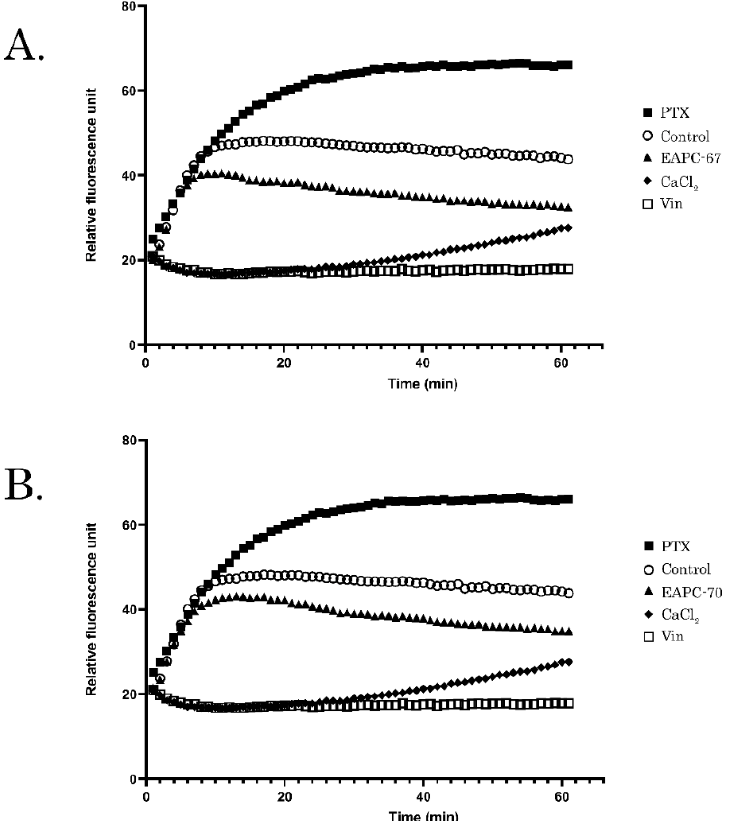
Figure 3. Dynamics of tubulin polymerization in samples treated with EAPC-67 ( A ) and EAPC-70 ( B ). Tubulin was also incubated with DMSO (control), Paclitaxel (PTX), Vinblastine (Vin), and CaCl2 at 37 °C, and absorbance was assessed every min for 1 h. A shift of the curve to the upper left of the control (DMSO) represents an increase in polymerized microtubules. A shift to the bottom right of the graph reflects the decrease in the rate of tubulin polymerization.